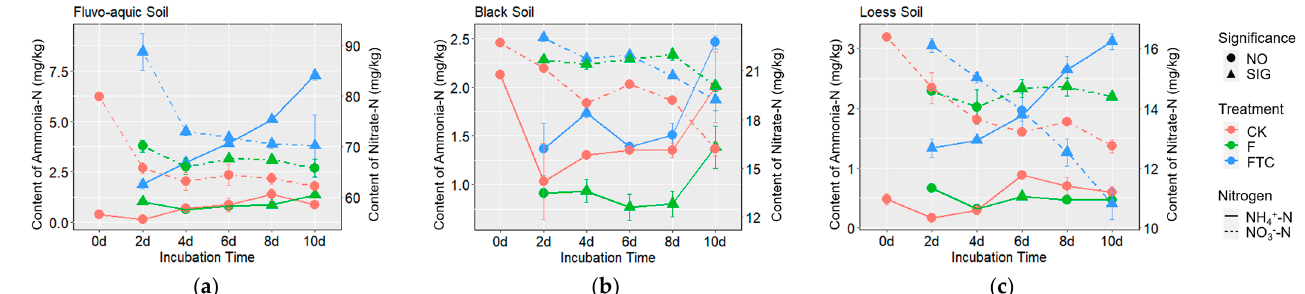
Figure 4. Changes in the soil NH 4+ -N and NO 3 − -N contents during anaerobic culture of fluvo-aquic soil ( a ), black soil ( b ) and loess soil ( c ). The dotted and solid lines show the variation trends of NH 4+ -N and NO 3 − -N content, respectively; “SIG” and “NO” indicate significant and non-significant differences in soil NH 4+ -N (or NO 3 − -N) content between the FTC or F and CK treatment at the same incubation time determined by Duncan’s test; CK: control treatment (10 °C); F: freezing treatment ( − 10 °C); FTC: freeze–thaw cycles ( − 10/10 °C).